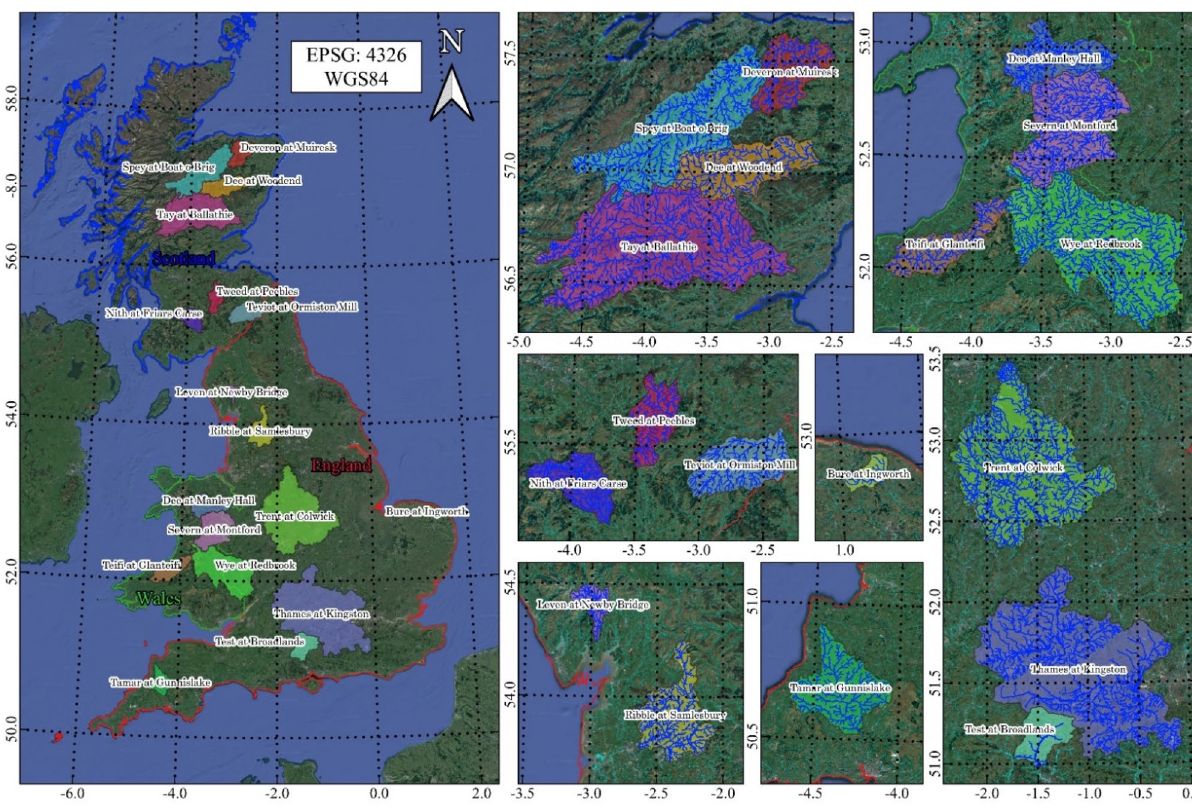
Figure 1. Location of the basins in UK. Maps created using the Free and Open Source QGIS 25 .